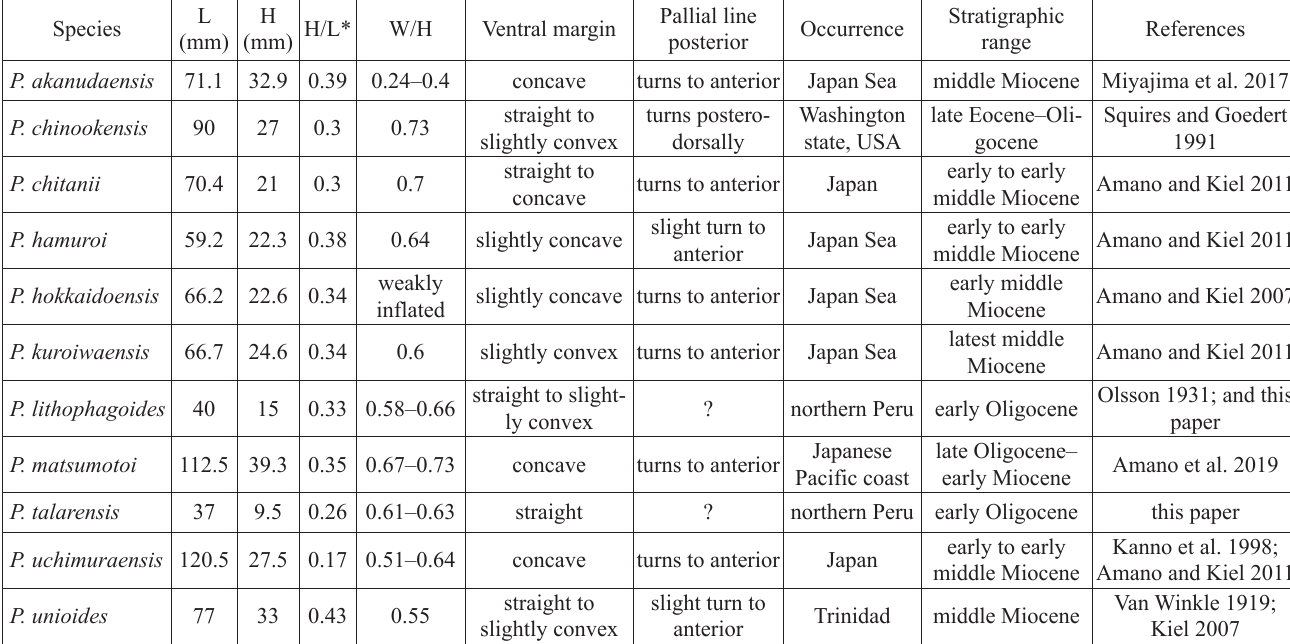
Table 1. Characters of the species of Pleurophopsis Van Winkle, 1919; * minimum values given only, because many Pleurophopsis species show allometric growth (i.e., they increase in length faster than in height). H, height; L, length; W, width.